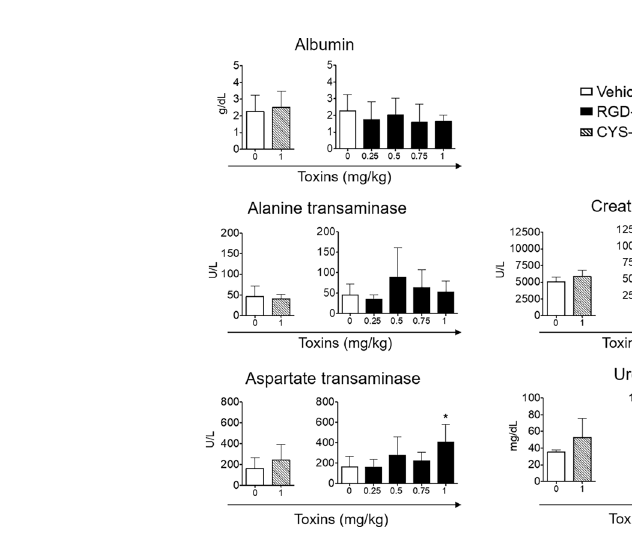
FIGURE 6 | Comparison of clinical biochemistry parameters in mice treated with CYS-SAP or different RGD-SAP concentrations. Blood samples were collected from treated mice and the concentration of albumin, alanine transaminase, aspartate transaminase, creatinine and urea in the serum were measured. Data are shown as mean ± SD from n = 4/6 mice per condition. Results from unpaired Student t test are shown. All treatments were compared to vehicle (*p < 0.05; **p <